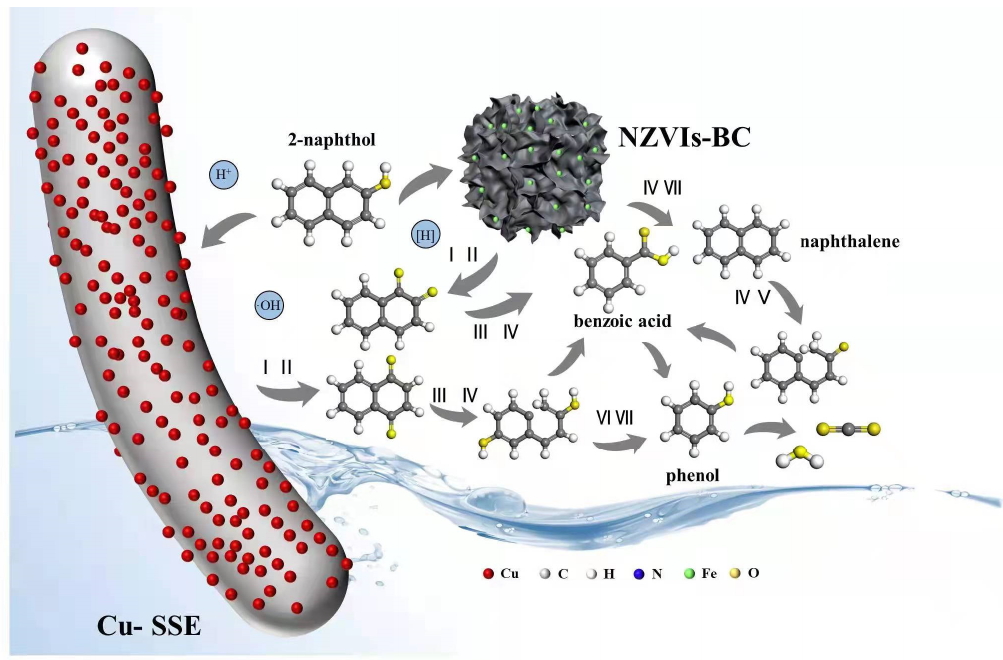
Figure 10. The possible degradation pathways of 2-naphthol in aqueous solution.